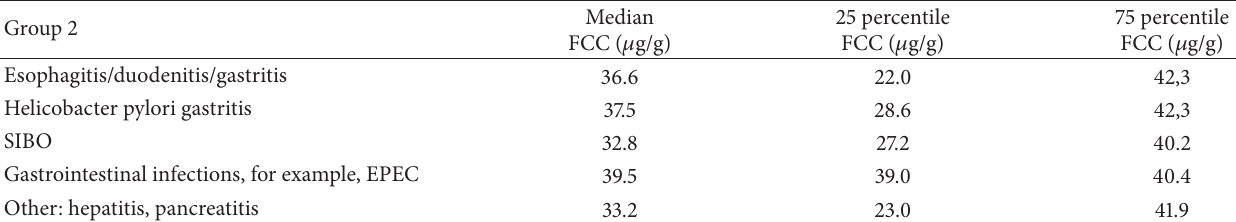
Table 2: Detailed characterization of Group 2 (patients with inflammatory gastrointestinal disorders other than IBD) with FCC distributions ( 𝑛 = 71 ).